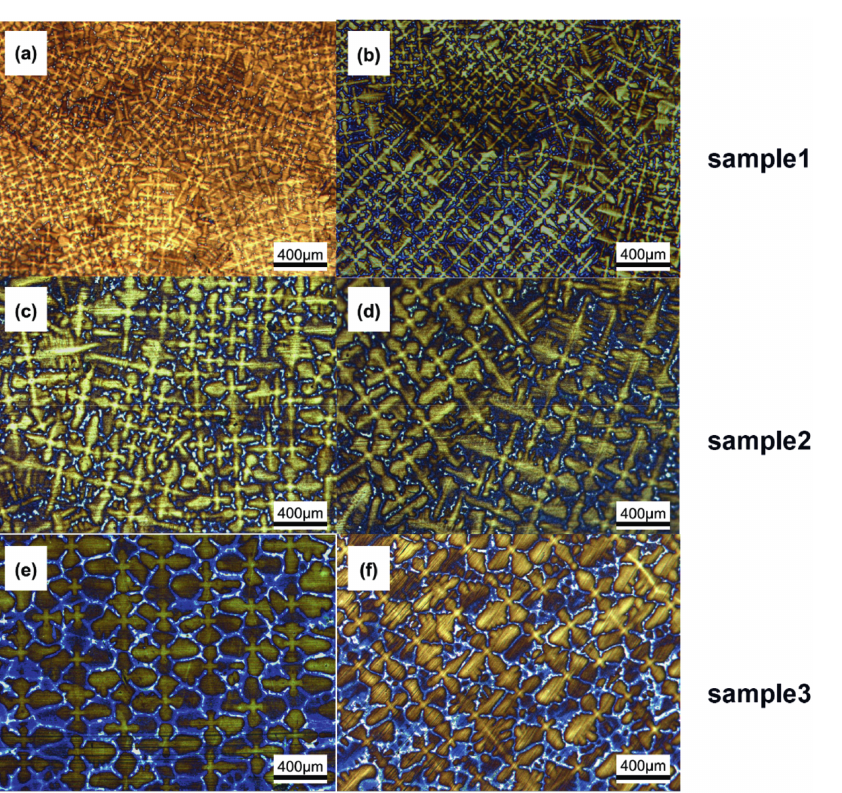
Figure 11: Transverse micrographs of samples in different locations: (a), (c) and (e) for the HRS process; (b), (d) and (f) for the LMC process.